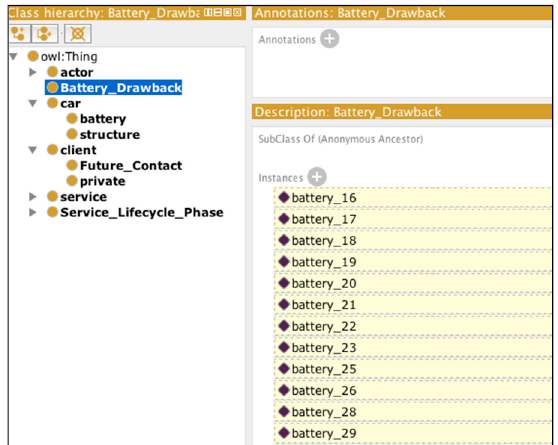
Figure 18. ‘Battery_Drawback’ inference example.